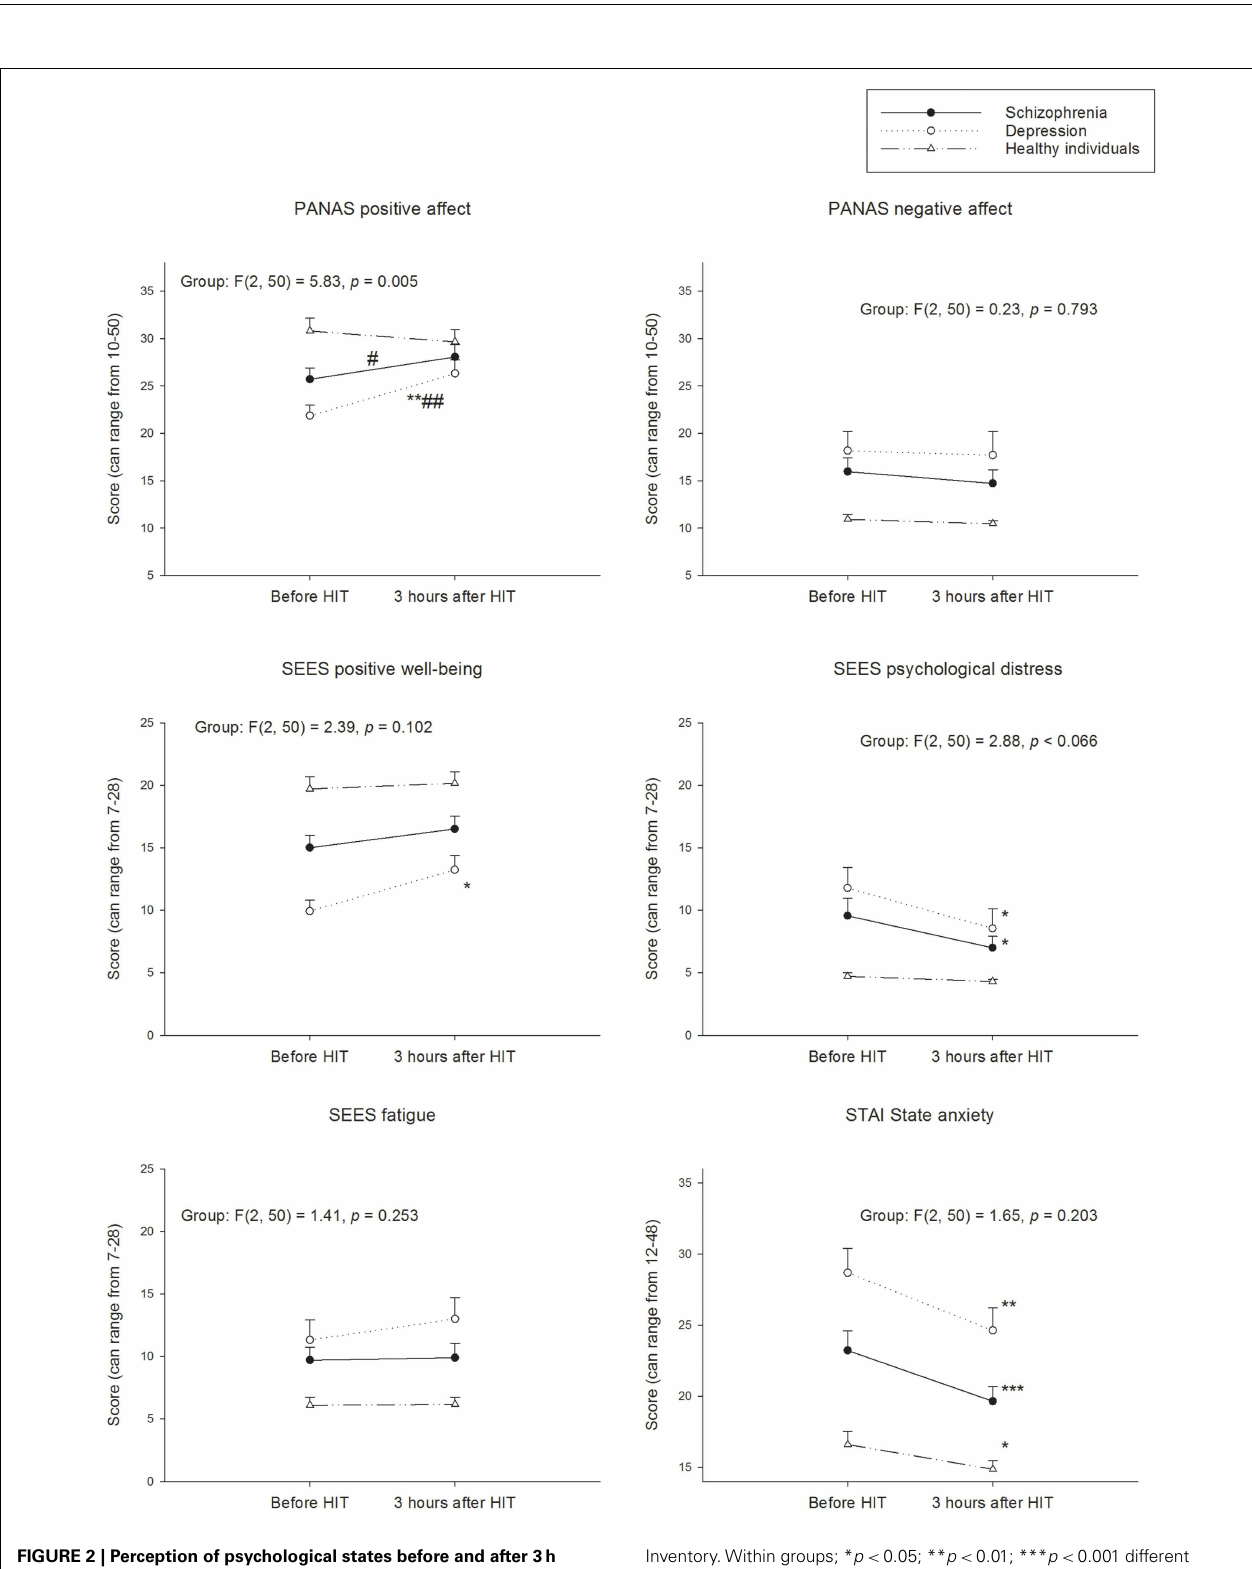
FIGURE 2 | Perception of psychological states before and after 3h after HIT . PANAS, Positive and Negative Affect Schedule; SEES, Subjective Exercise Experiences Scale; STAI, State-Trait Anxiety